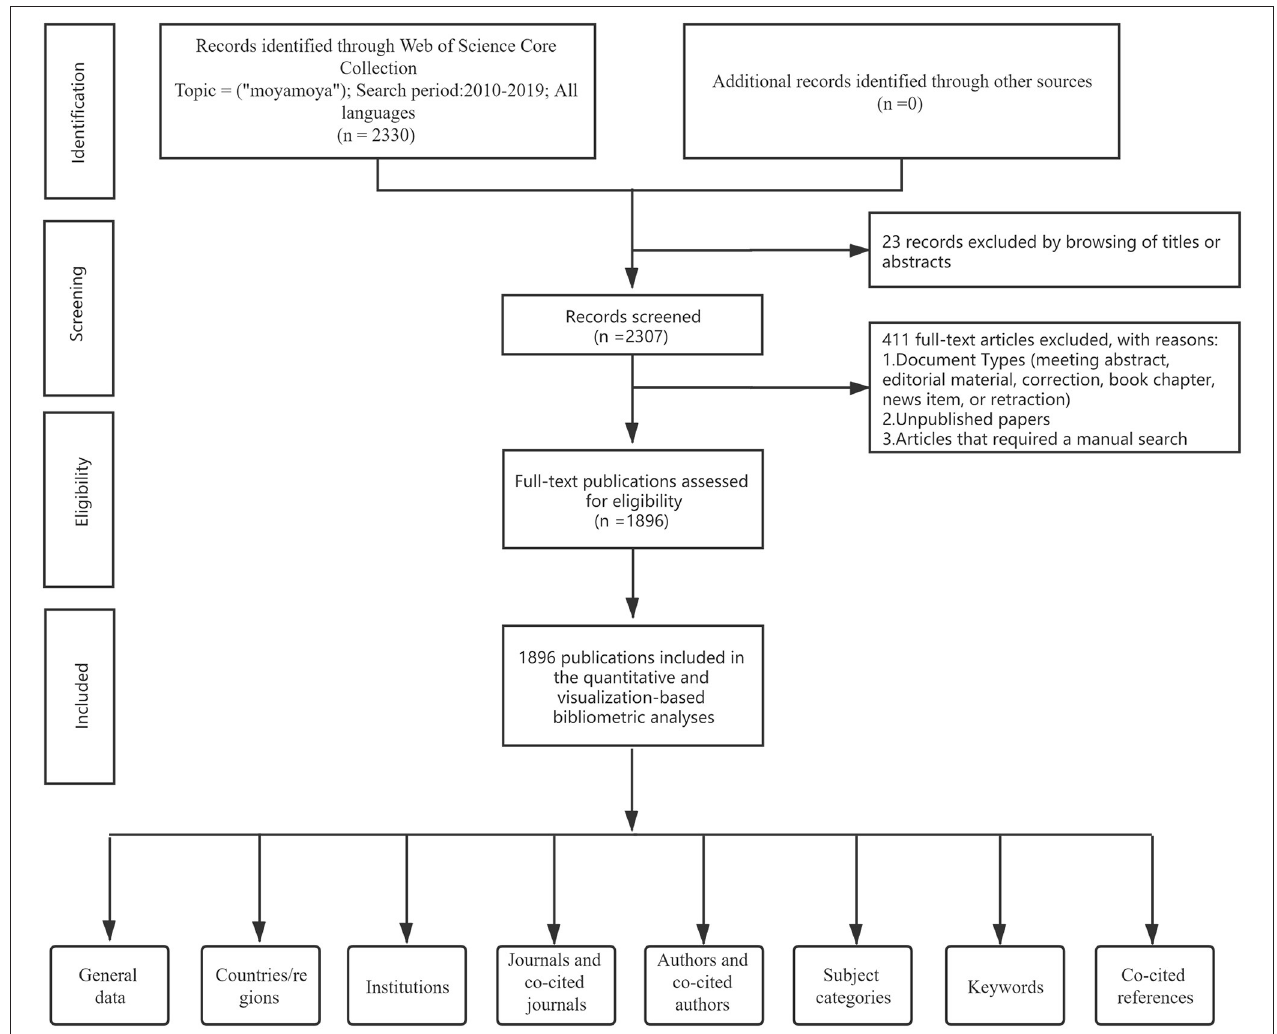
FIGURE 1 | A frame flow diagram. The diagram showed detailed search strategies and selection criteria for MMA publications from WoSCC database and the steps of bibliometric